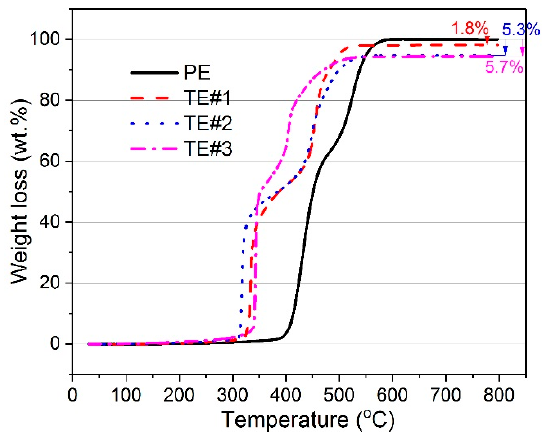
Figure 5. Weight loss of TiO 2 -coated electrospun fibers with different self-assembly cycles.